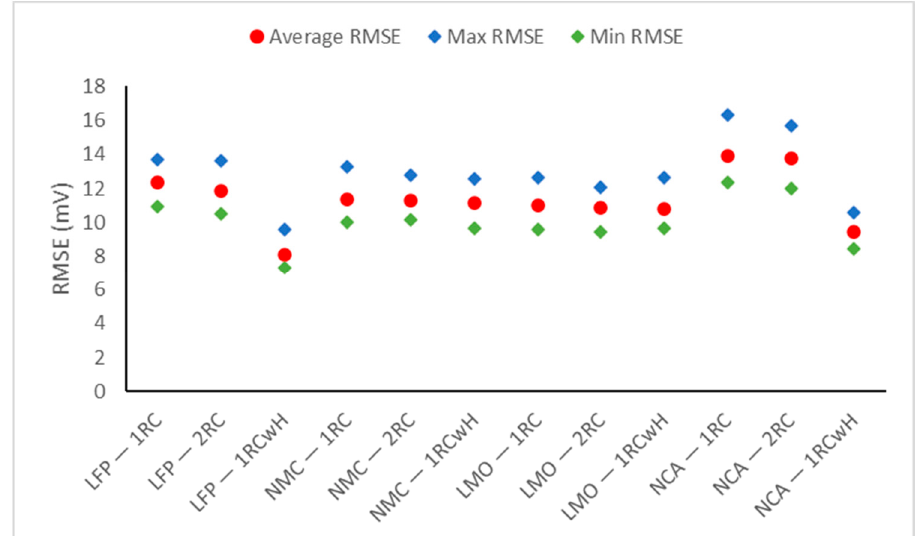
Figure 9. Model validation performance of different equivalent circuit models for various lithium-ion cell chemistries under the ND cycles.